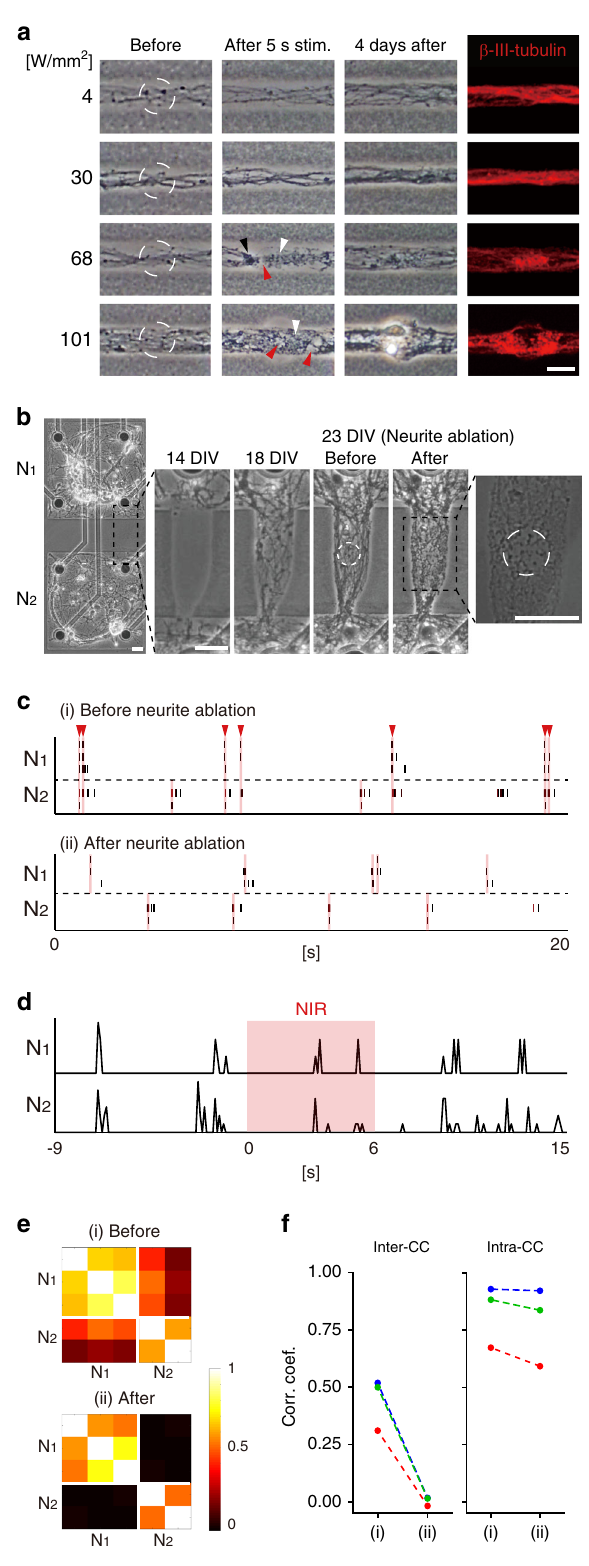
(Fig. 4a, white dashed circles). The focused NIR laser (785 nm, beam diameter: 20.5 μ m) with 4, 30, 68, and 101 W/mm 2 (1, 10, 22, and 33 mW) was illuminated for 5 s. This power range was determined based on a previous study on the effect of a ther- moplasmonic laser power on neural spiking activity, which showed irreversible loss of neural activity at 60.8 W/mm 2